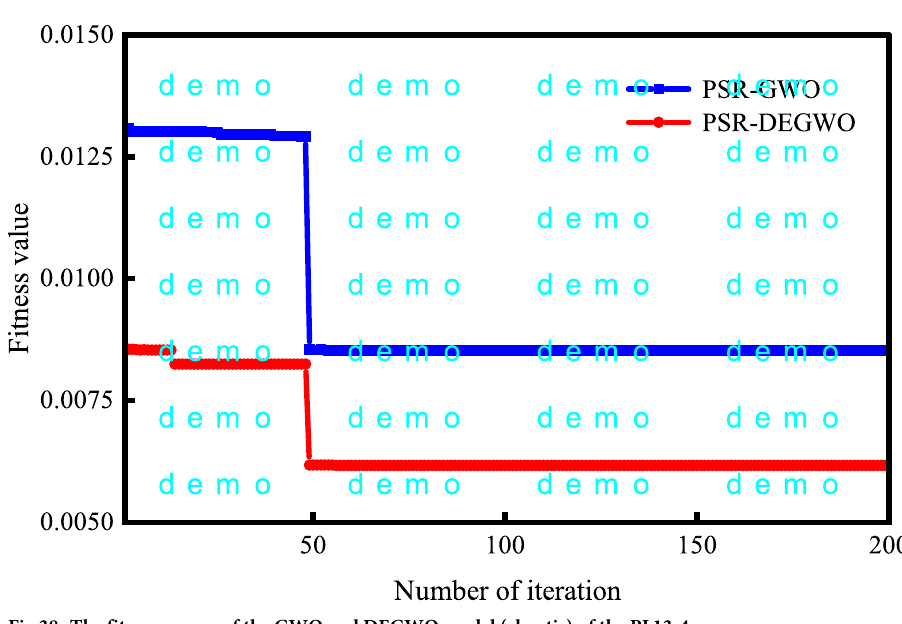
Fig 38. The fitness curves of the GWO and DEGWO model (chaotic) of the PL13-4.